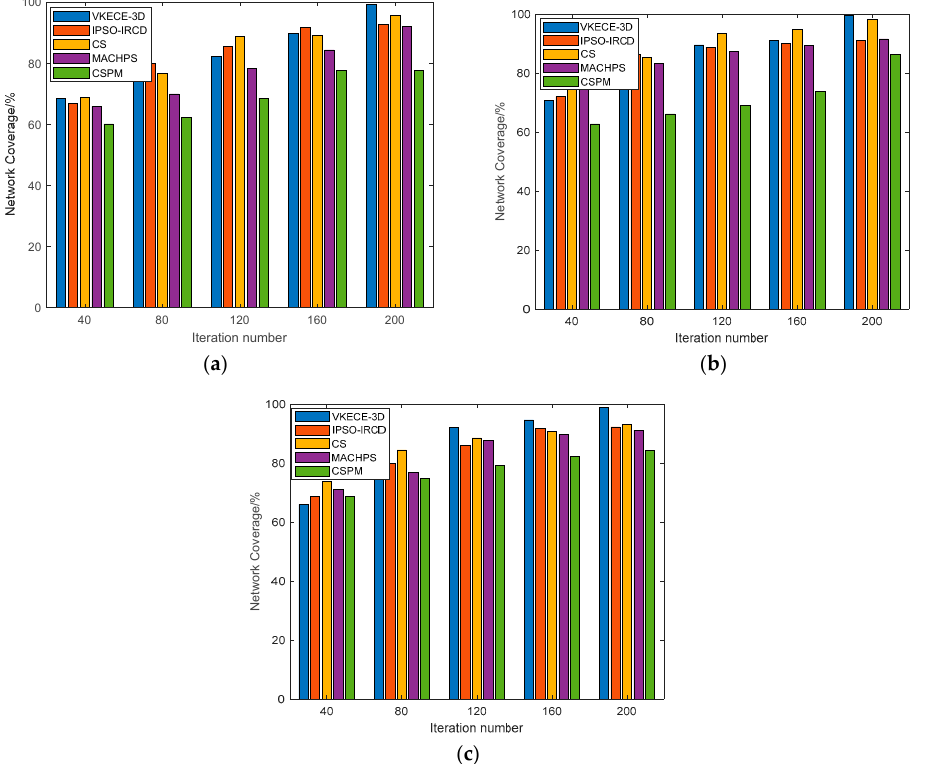
Figure 14. Coverage of our proposed algorithm vs. comparison algorithms: ( a ) the small network, N = 100; ( b ) the medium-sized network, N = 250; ( c ) the large networks, N = 500.